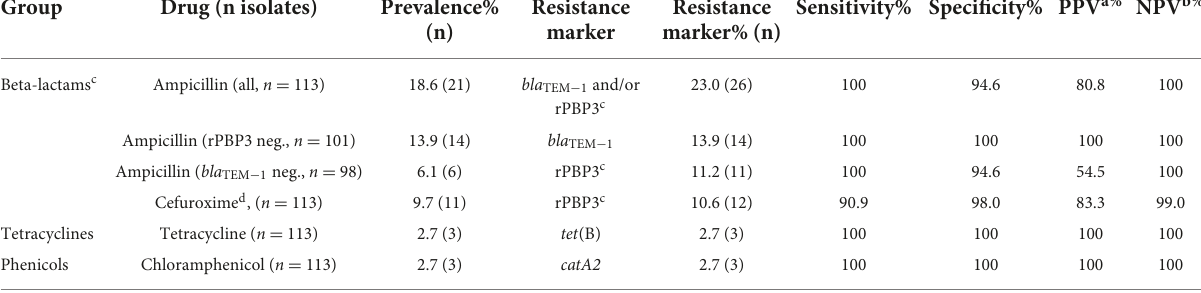
TABLE 5 Prevalence of phenotypic resistance, and correlation between phenotypic antibiotic resistance and presence of genetic resistance markers (genes and mutations) in 113 invasive Hi isolates from 2017, 2020 and 2021, Norway, where both WGS data and AST data were available.